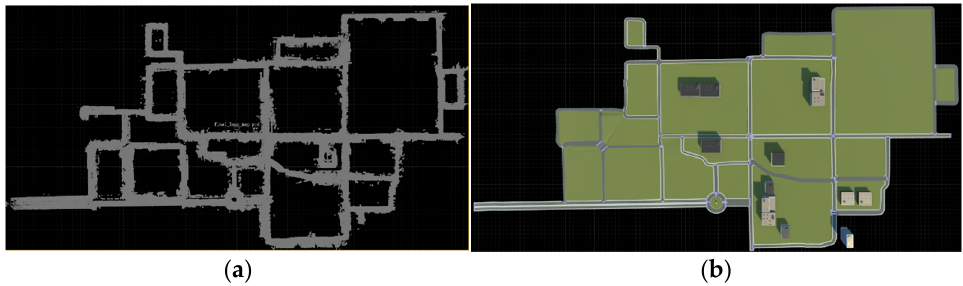
Figure 20. ( a ) Point cloud map of the test site at Changchun, China. ( b ) Lane-level electronic map of the test site at Changchun, China.